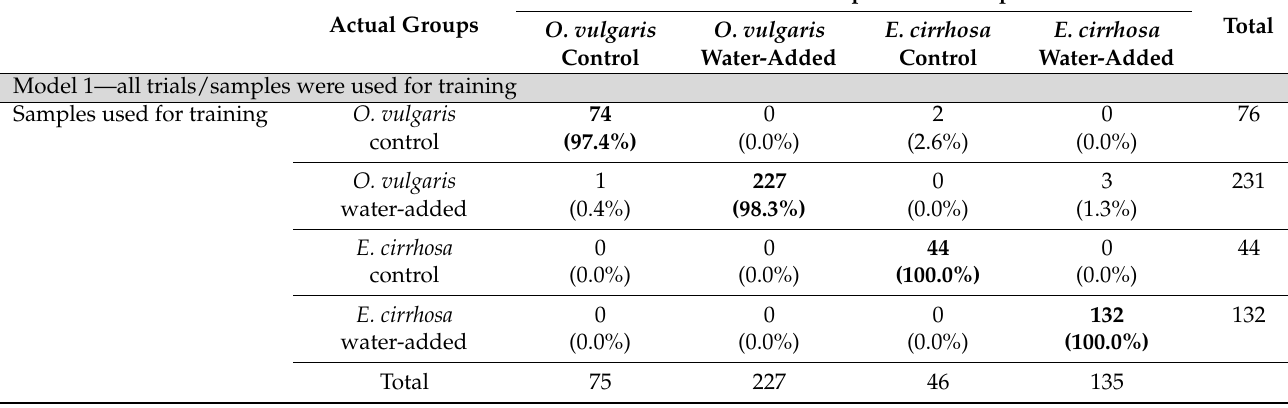
Model 1—all trials/samples were used for training Samples used for